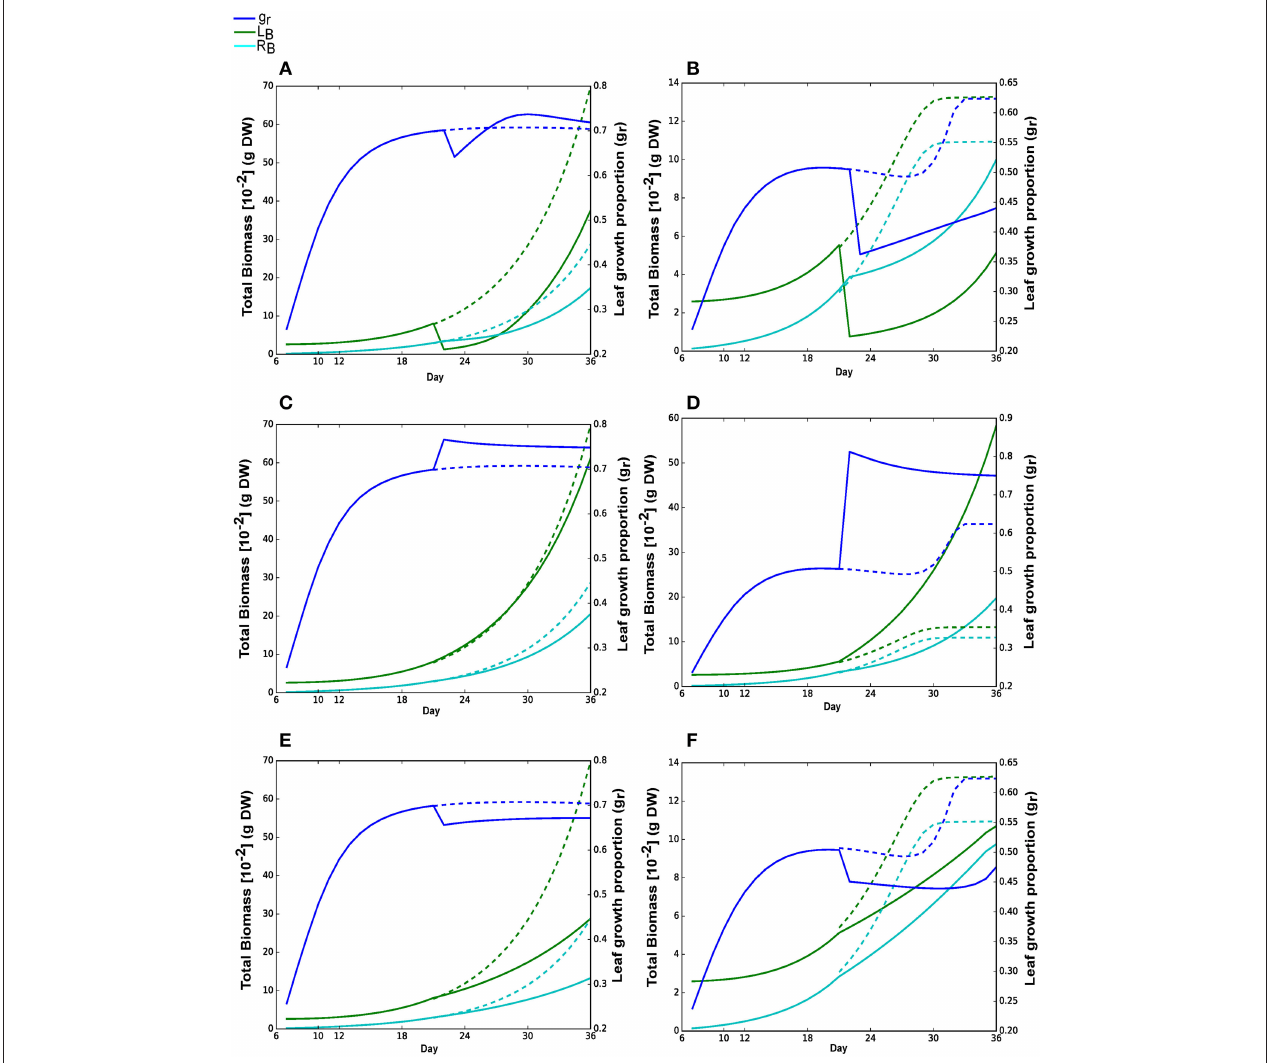
FIGURE 6 | Metabolic responses to physiological and environmental perturbations. All perturbations (A–F) were imposed on day 21. Solid lines are the results with perturbations; dashed lines are the growth curves for N high or N low without perturbation. Blue, green and cyan lines represent leaf growth proportion (g r ), leaf and root biomass, respectively. (A,B) Reduction in leaf biomass on day 21 to 0.001g under N high and N low , respectively. (C,D) Increase in nitrate concentration to 100 mmol under N high and N low , where simulations were started with 50 mmol and 1.2 mmol nitrate concentrations under N high and N low , respectively. (E,F) Incident